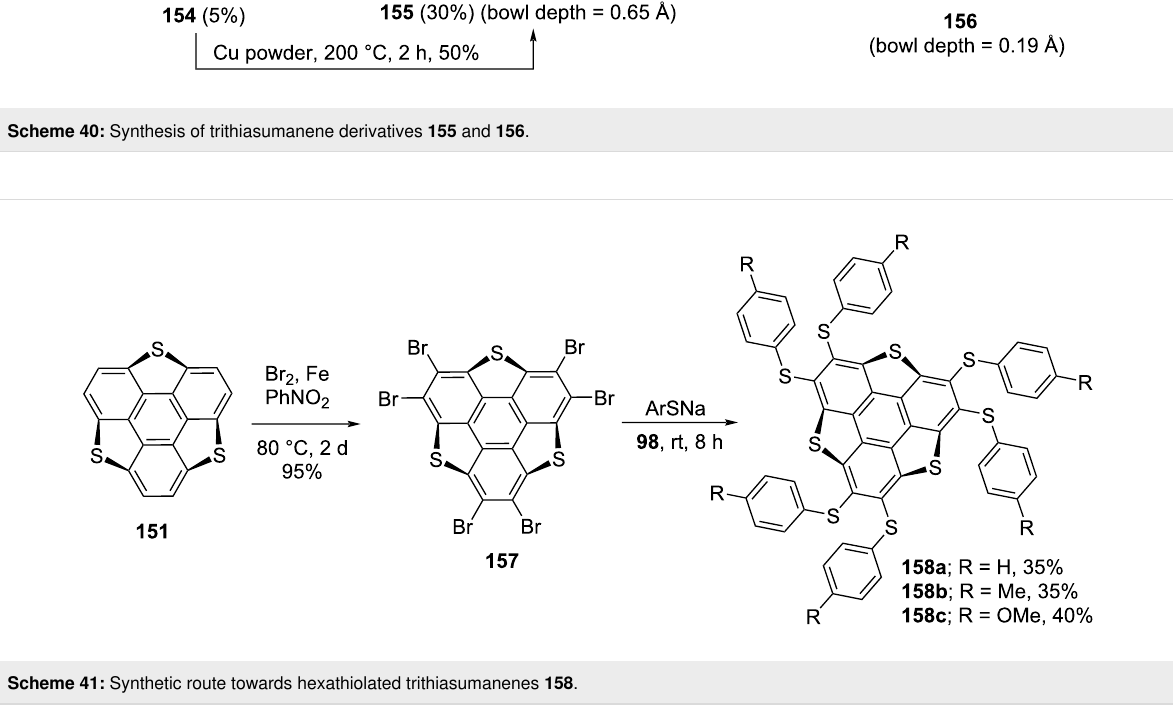
Scheme 40: Synthesis of trithiasumanene derivatives 155 and 156 .